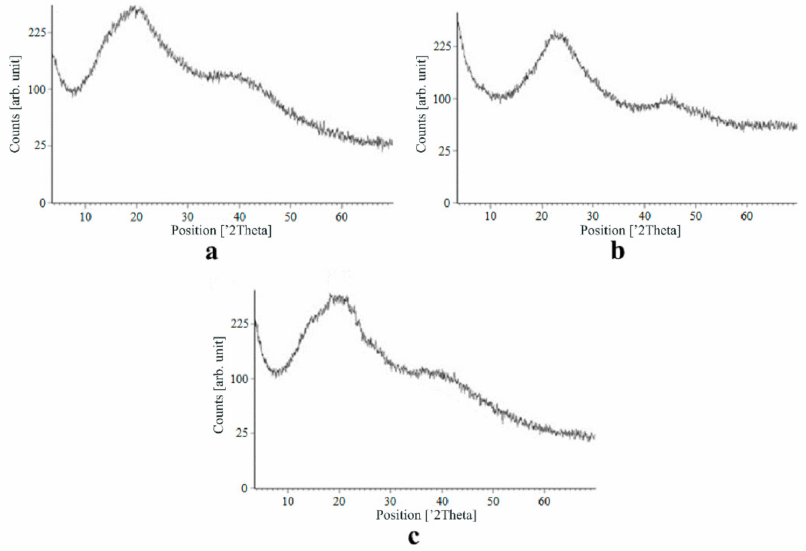
Figure 8. X-ray di ff raction patterns of ketoprofen loaded into the alginate-based aerogel: ( a ) 18.05, ( b ) 19.36, ( c ) 26.98